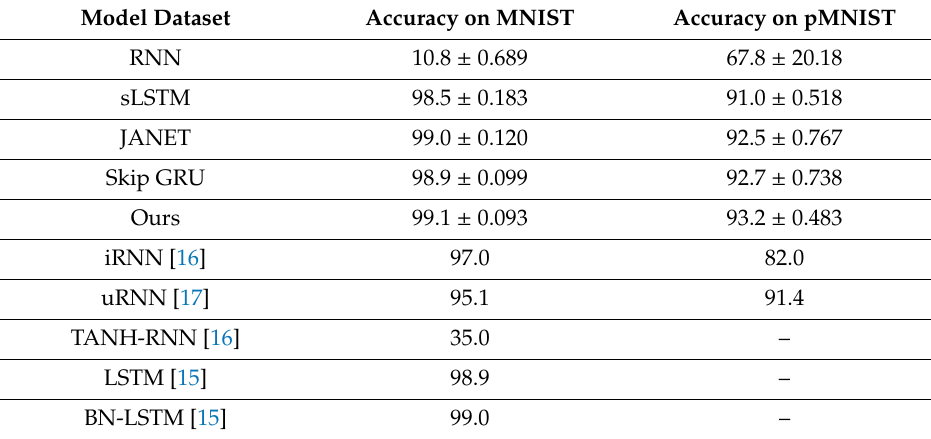
Table 3. Results of the testing accuracy.